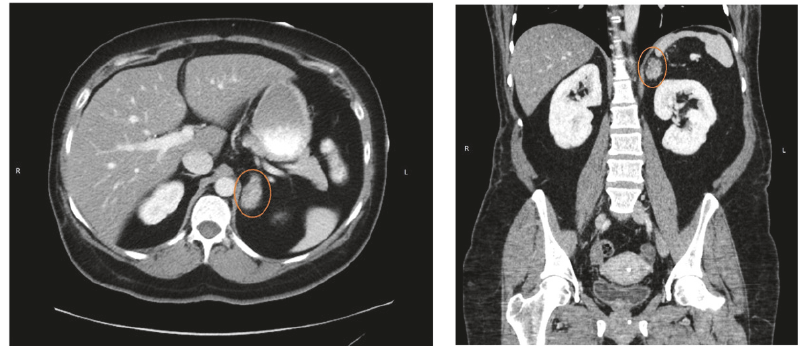
Figure 1: Images showing left adrenal adenoma measuring 2.9 × 1.9 × 2.5 cm (shown in circles).